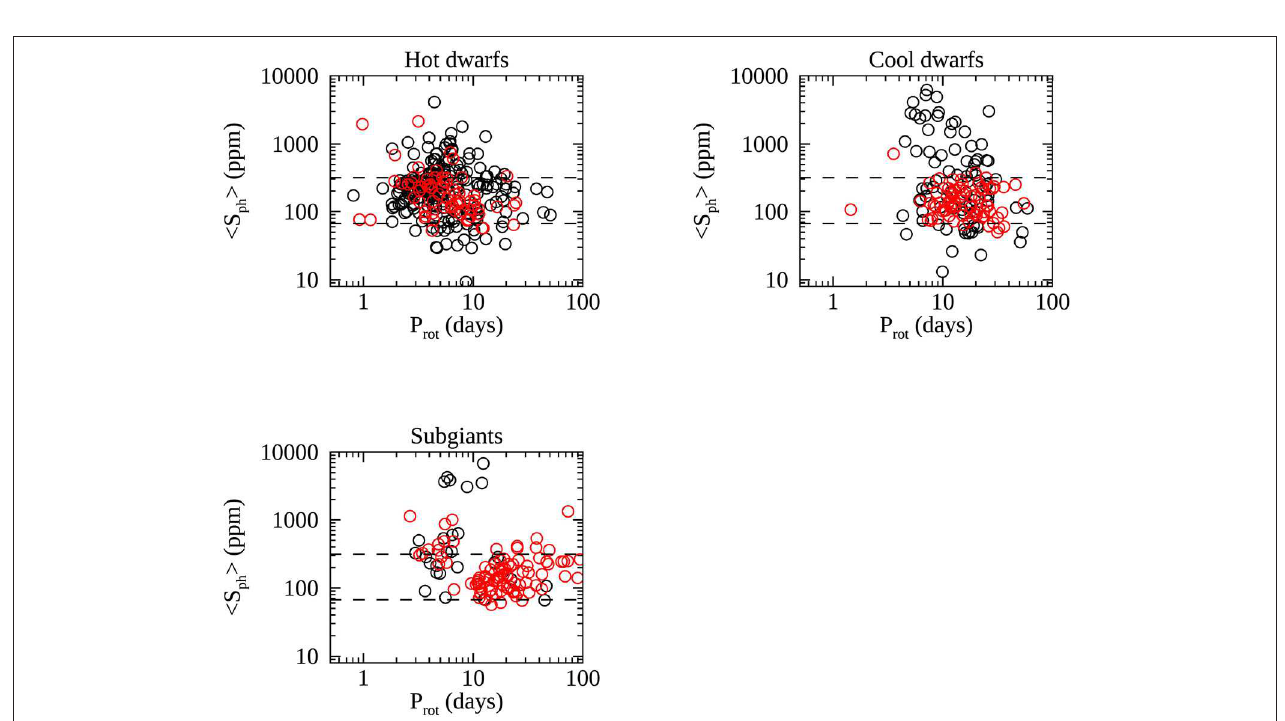
FIGURE 12 | Same as Figure 10 but separated into the three categories of stars: hot dwarfs, cool dwarfs, and subgiants.